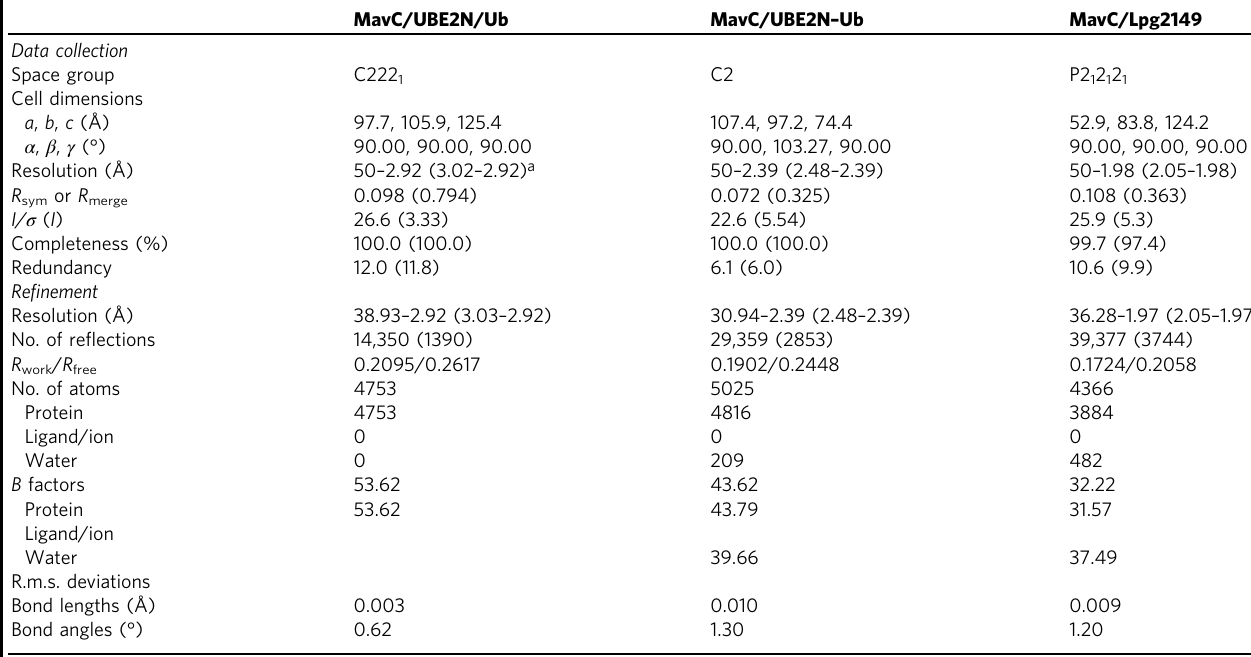
Table 1 Data collection and re fi nement